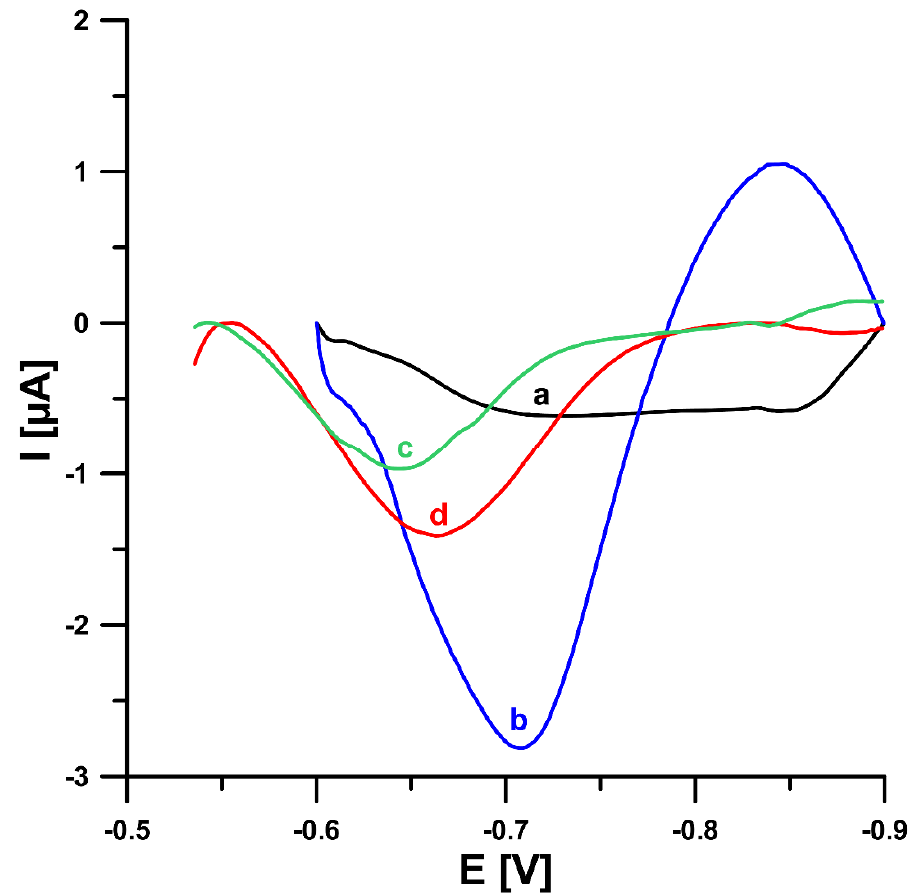
Figure 1. Comparison of the DPAdSV curves registered for 1.0 × 10 − 8 mol L − 1 V(V) at the GCE/PbF in 0.3 mol L − 1 acetate buffer solution (CH 3 COONa and CH 3 COOH) of pH 5.6 ± 0.1 ( a , c ) or in 0.3 mol L − 1 buffer solution (CH 3 COONH 4 , CH 3 COOH, and NH 4 Cl) of pH 5.6 ± 0.1 ( b , d ) in the presence of 3.0 × 10 − 4 mol L − 1 Pb(NO 3 ) 2 and 7.0 × 10 − 4 mol L − 1 cupferron ( a , b ) or 3.0 × 10 − 4 mol L − 1 Pb(NO 3 ) 2 , 3.0 × 10 − 5 mol L − 1 chloranilic acid and 1.0 × 10 − 2 mol L − 1 bromate ions ( c , d ). The parameters: − 1.1 V (E dep. Pb ) for 20 s (t dep. Pb ), − 0.6 V (E acc. ) for 30 s (t acc. ), 100 mV ( Δ E A ), 20 mV s − 1 ( ν ), and 2 ms (t m ).